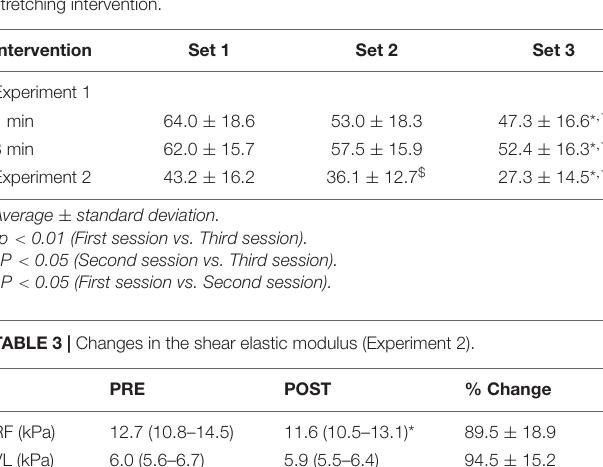
TABLE 2 | Changes in the visual analog scale (VAS) values during the stretching intervention.